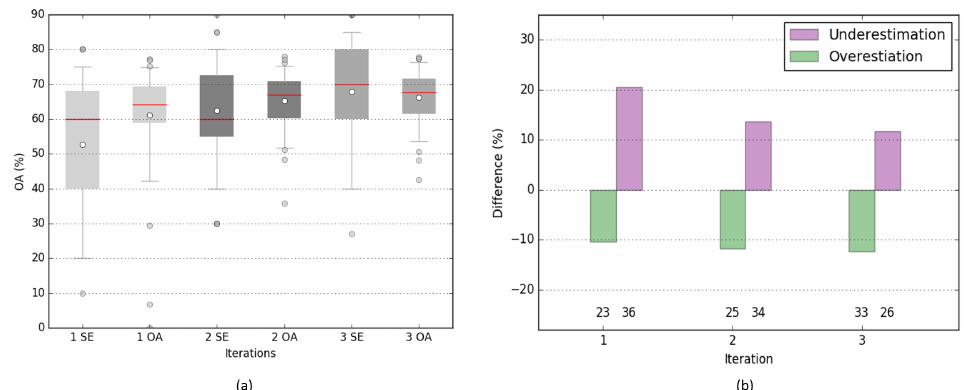
Figure 2. ( a ) Boxplots of self-estimated (SE) and actual (OA) overall accuracy for each iteration. Median OA: red stripe; average OA: white dot; boxplot ends: first and third quantile; whiskers: + / − the 1.5 fold interquartile range on OA values and outliers: grey dots. ( b ) Difference between self-estimated and actual overall accuracy. Numbers beneath the bars indicate the number of participants who respectively under- or overestimated the mapping accuracy.